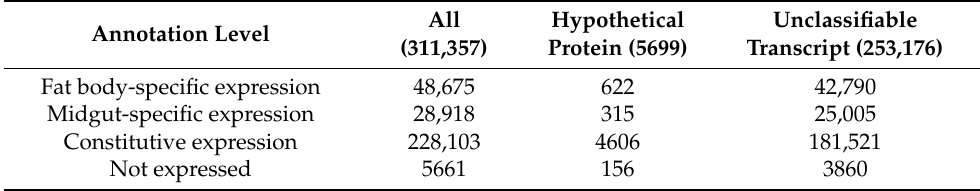
Table 3. Functional annotation from expression for E. okinawaensis